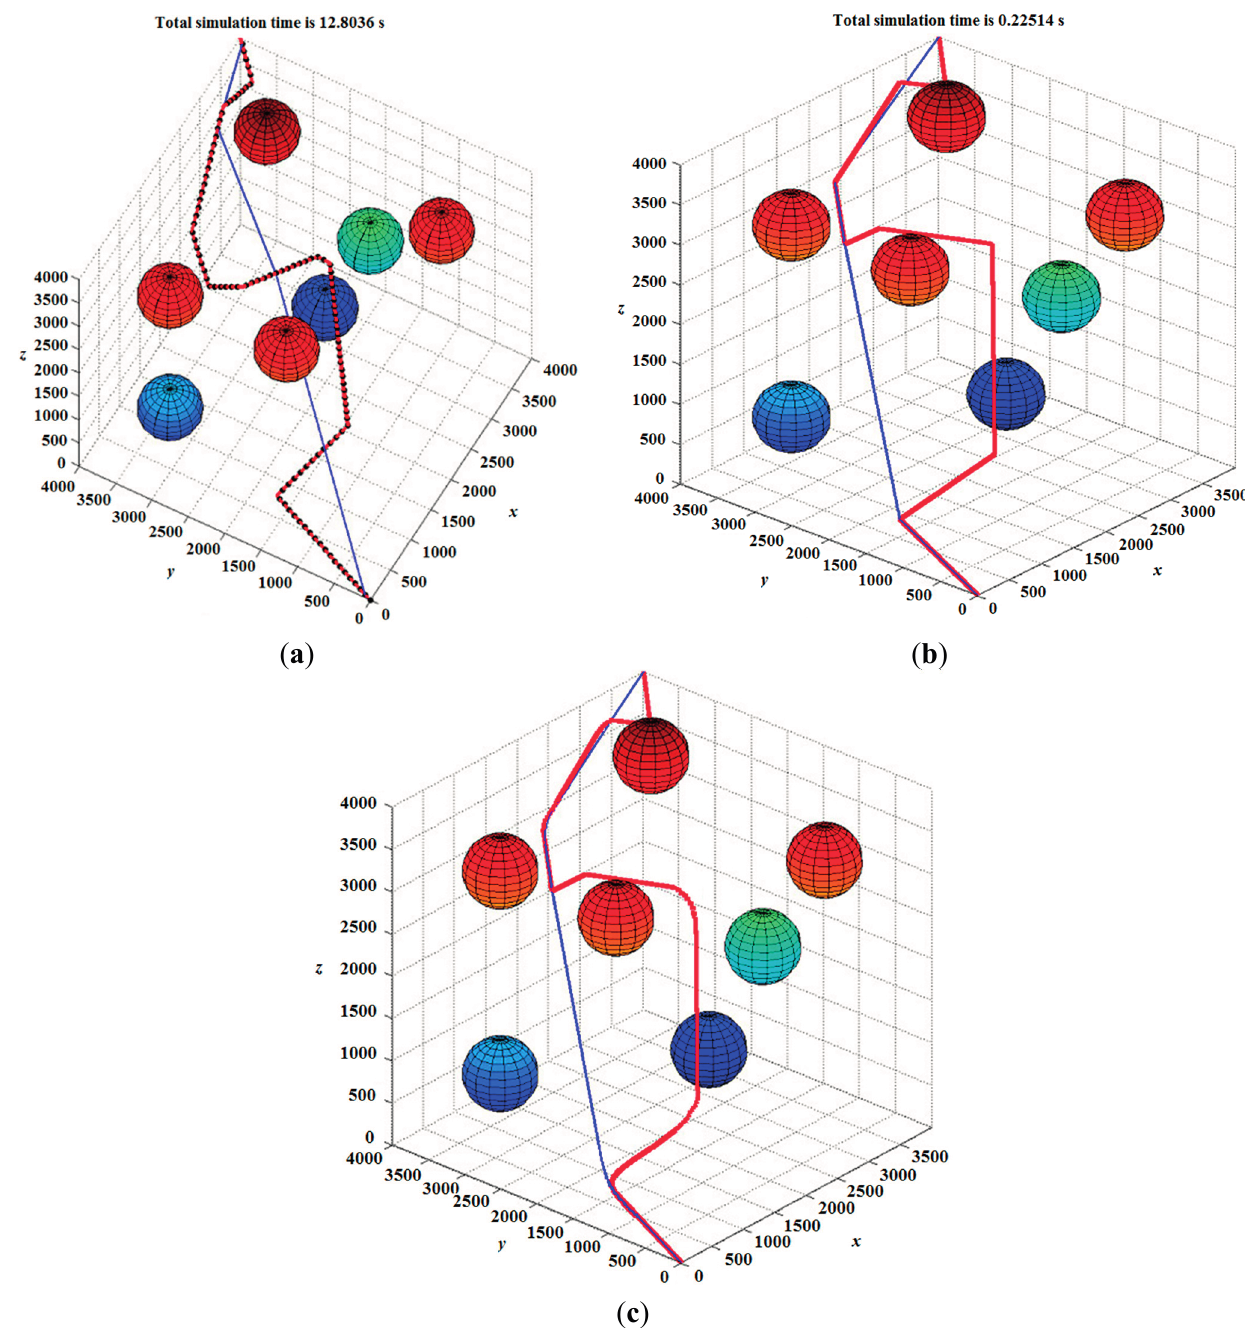
Figure 15. Flight paths generated by different algorithms under the same scenario: ( a ) RRT (red-dotted line) and Dijkstra algorithms (blue line); ( b ) integrated multi-RRT (red line) and improved A-star algorithms (blue line) (unit: m); and ( c ) multi-RRT (red line) and improved A-star (blue line) and Bezier curving refinement (unit: